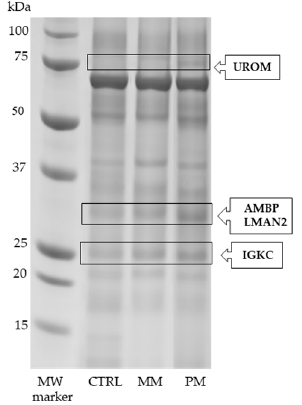
Figure 1. SDS-PAGE urinary protein profile. The differentially expressed bands among the three groups are bordered by rectangles, alongside the abbreviated protein names: UROM (uromodulin), AMBP (alpha-1-microglobulin), LMAN2 (vesicular integral-membrane protein VIP36), IGKC (immunoglobulin kappa constant). First lane: molecular weight (MW) marker, expressed as kDa (PrecisionPlus Protein Standards, Bio-Rad); CTRL, control group; MM, menstrually related migraine group; PM, post-menopause migraine group. Table 1. Differentially expressed proteins detected by SDS-PAGE and identified by LC-MS/MS analysis.